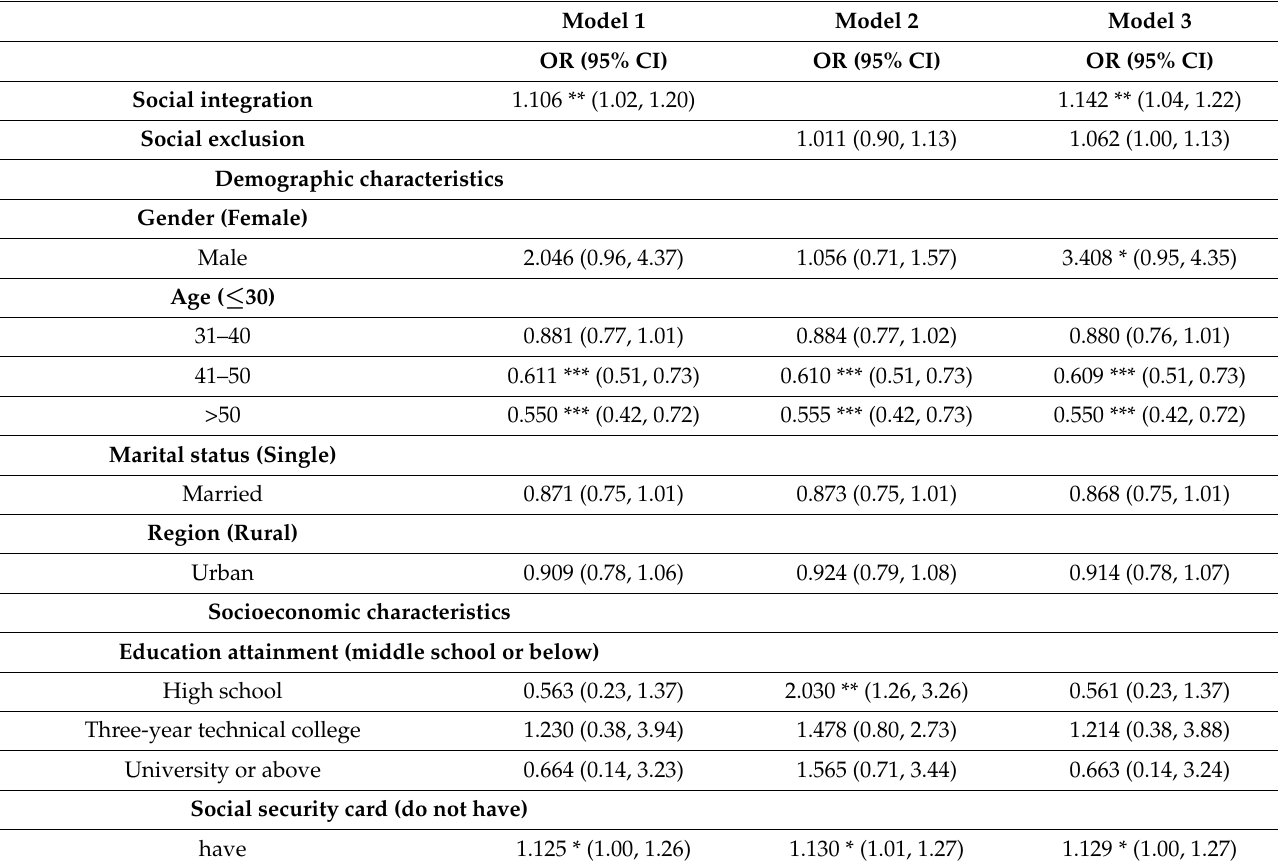
Table 2. Association of social integration, social exclusion, and influenza vaccination of migrants in the multivariable